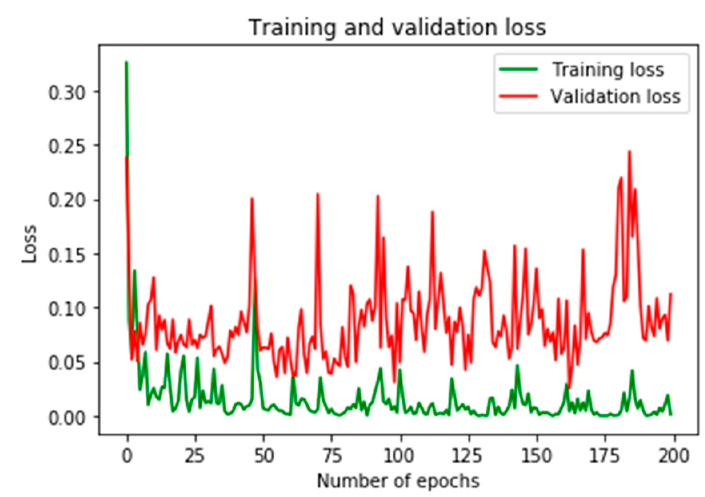
Figure 11. Showing training and validation losses using ResNet101 .